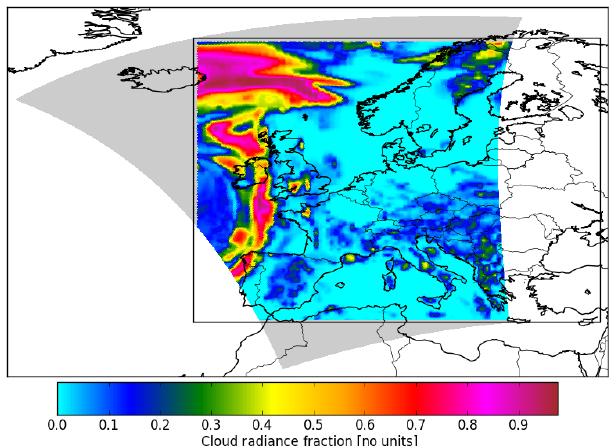
Figure 2. Example of the distribution of cloud radiance fractions for the simulated S5P 12:34UTC overpass on 1 June 2003. The rectangle represents the European modelling